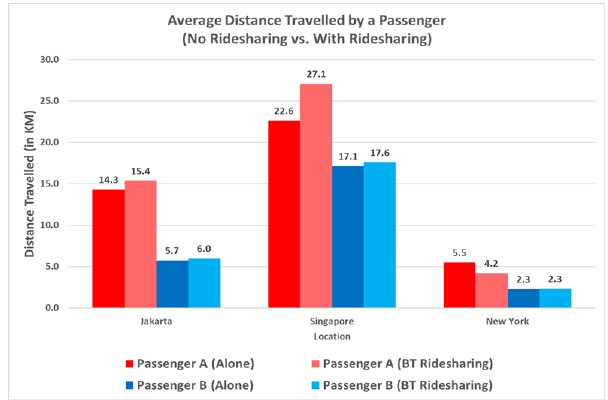
Figure 6. Comparison of average traveled distance under No Ridesharing and with